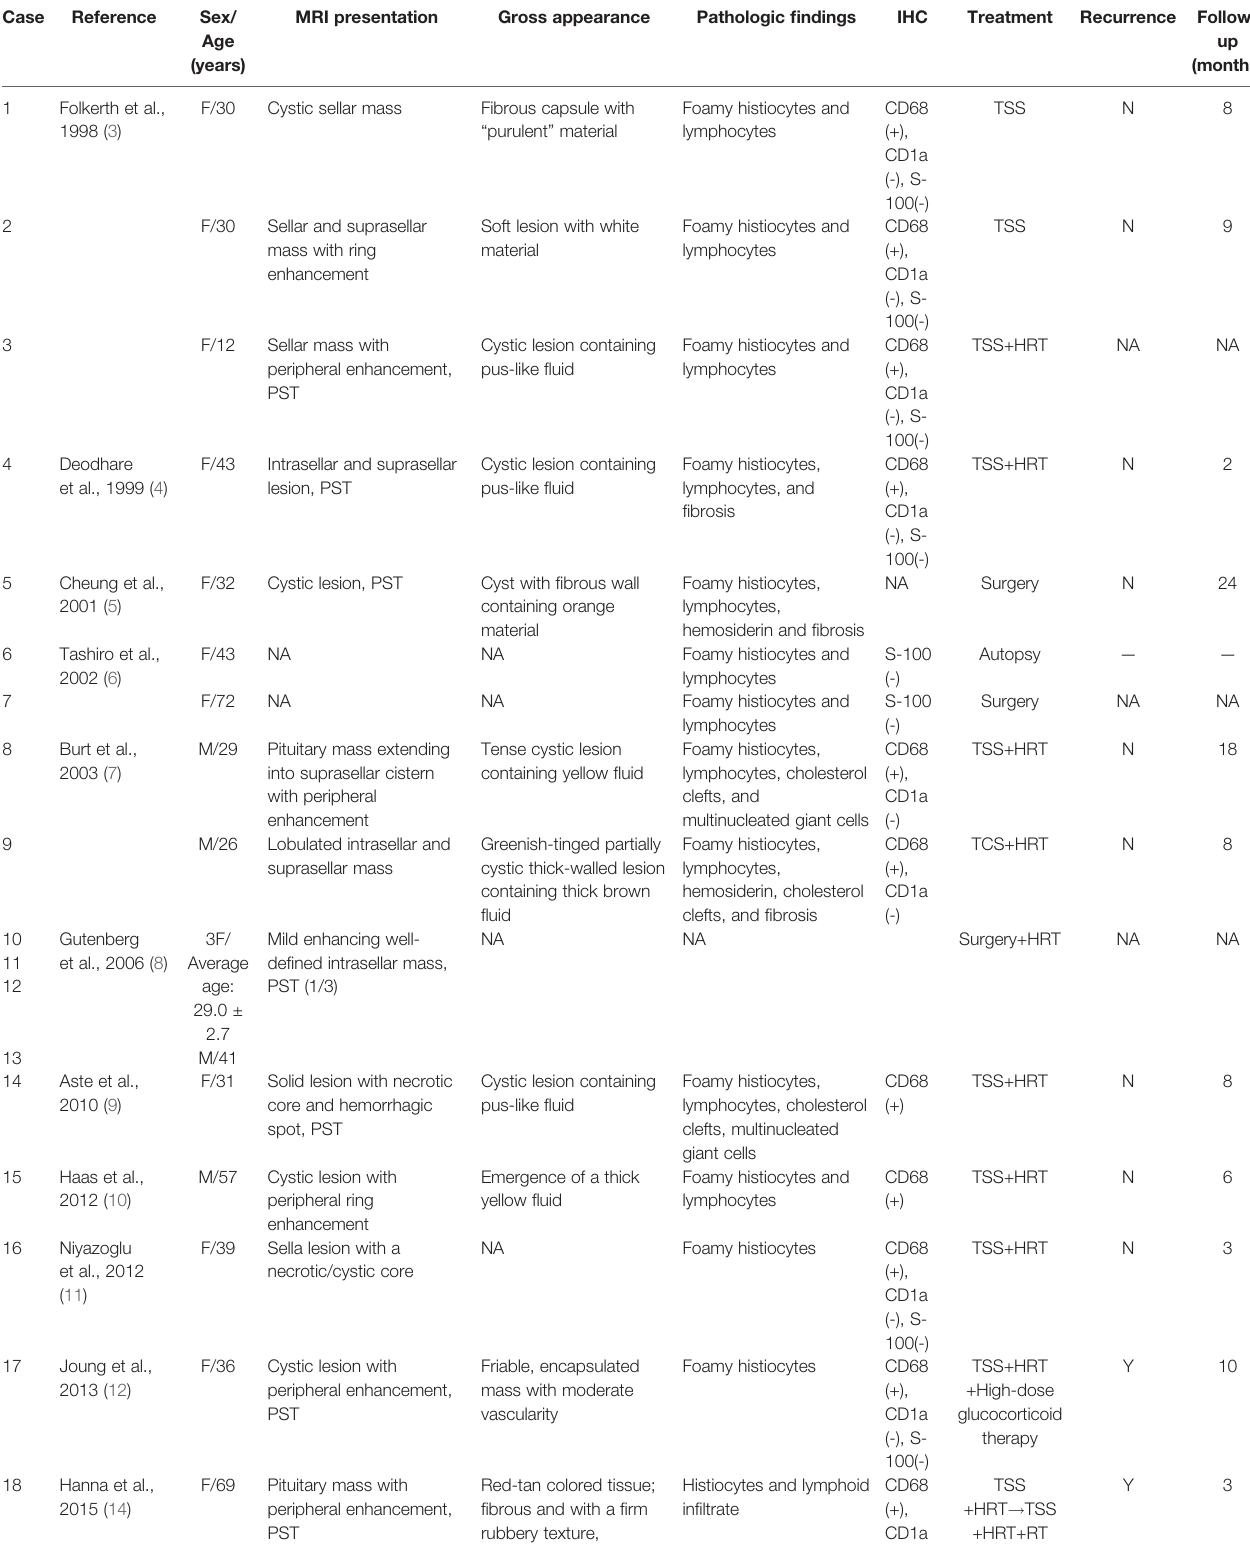
TABLE 2 | Review of 36 cases of xanthomatous